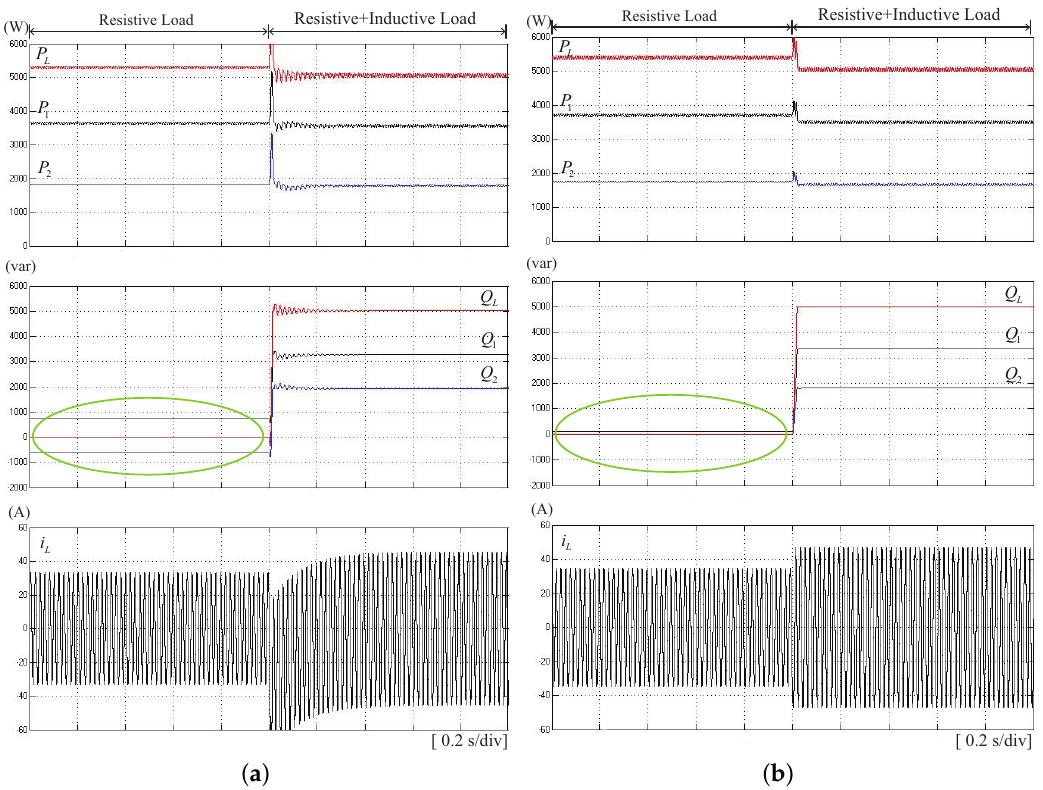
Figure 11. Power and current waveforms at the step load change: ( a ) conventional droop method; ( b ) proposed active impedance